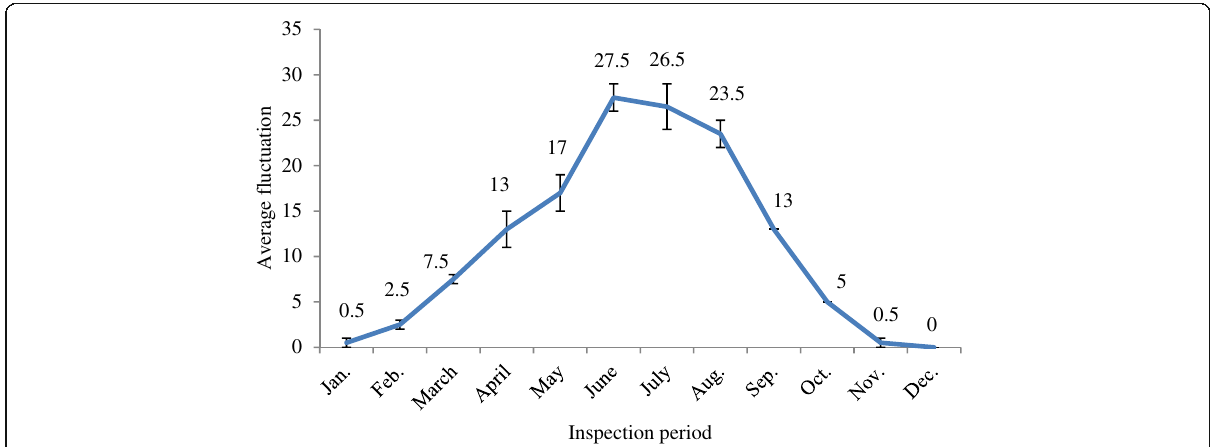
Fig. 2 Average monthly fluctuation of Phonapate frontalis adults (mean catch/2 traps ± SE) at Siwa date palm groves (2016